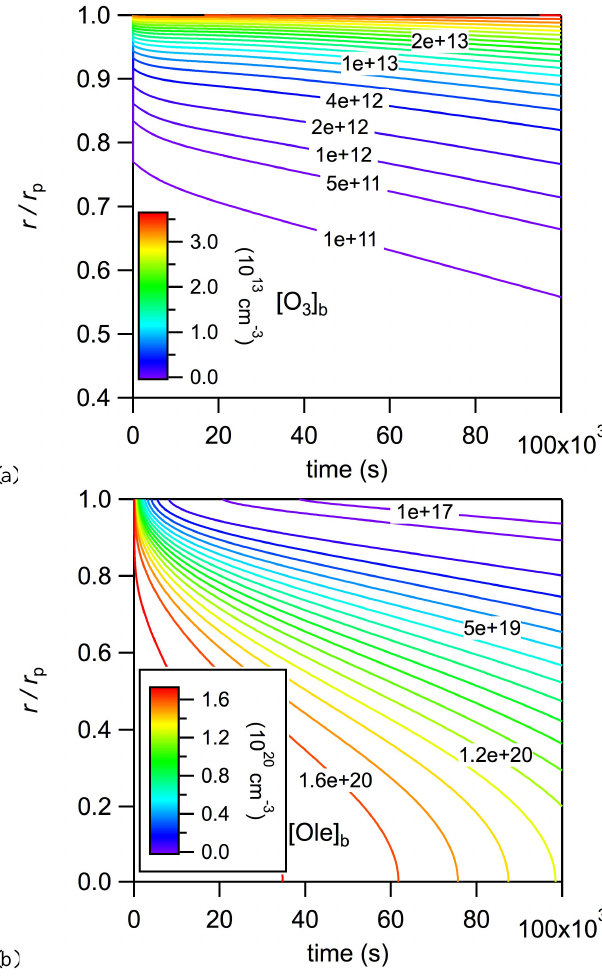
Fig. 5. Bulk concentration profiles of (a) ozone and (b) oleic acid for the diffusivity-evolution model. Equivalent plots for the constant-diffusivity model variant are presented in the Supplement in Fig. S1a and b.